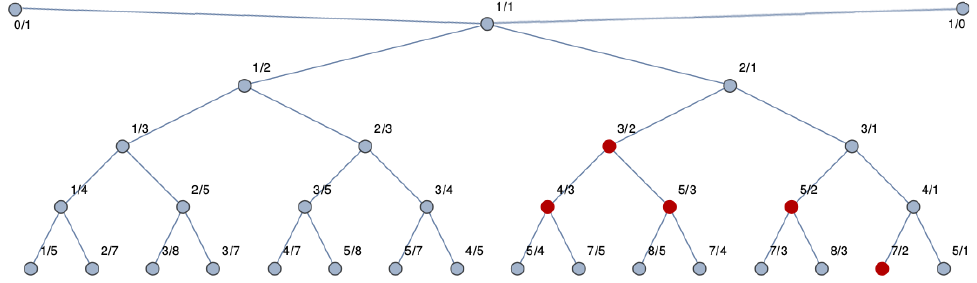
Figure 9. A view of the sum of continued fraction coe(cid:14)cients in the Stern-Brocot tree of positive rational numbers. Namely, P b i = d n;m is the depth of the fraction n in the tree. The red nodes i m highlight the locations of some of the torus knots illustrated in (cid:12)gure 3, namely K 3 ; 2 ; K 5 ; 2 ; K 7 ; 2 ; K 4 ; 3 , and K 5 ; 3 (the remaining ones appear in deeper levels not shown in the